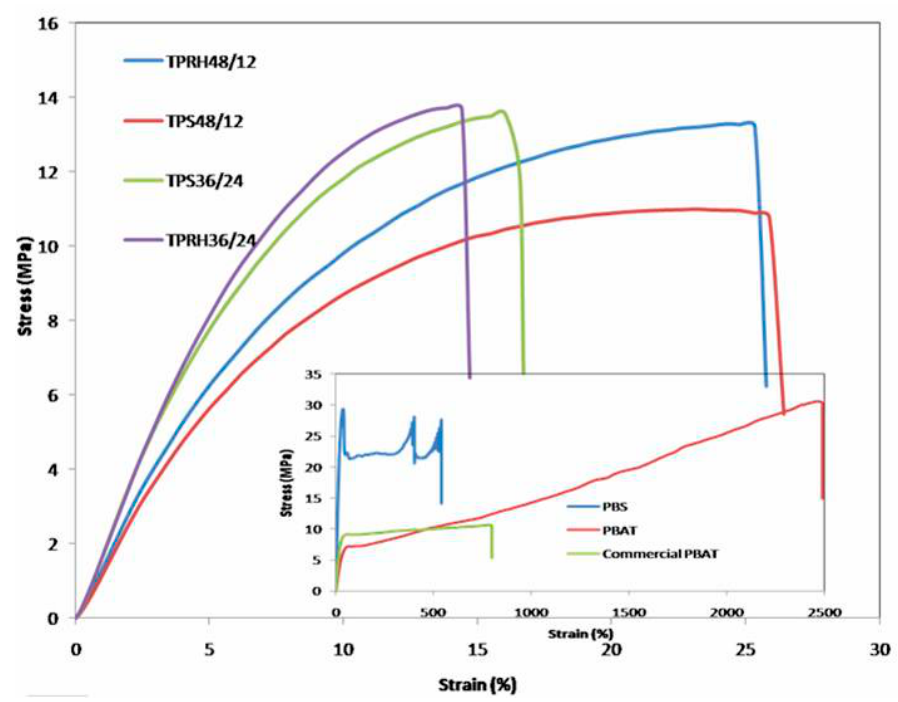
Figure 3. Stress–strain curves of PBS/PBAT/TPRH and PBS/PBAT/TPS composites. Table 3. Tensile strength, Young’s modulus, and elongation at break for PBS/PBAT/TPS and PBS/PBAT/TPRH